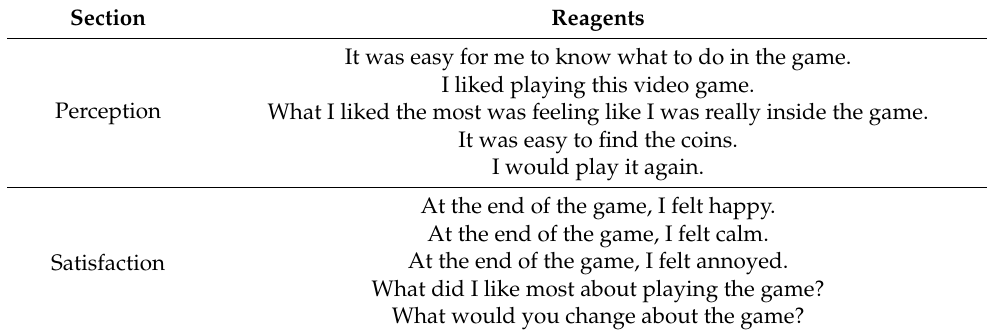
Table A1. Reagents from the questionnaire used to evaluate the perception of use and satisfaction.